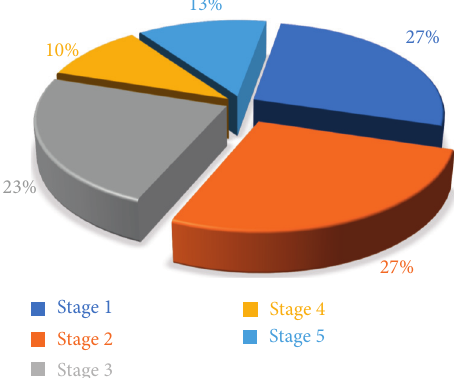
Figure 4: The distribution of the weight of the risk control